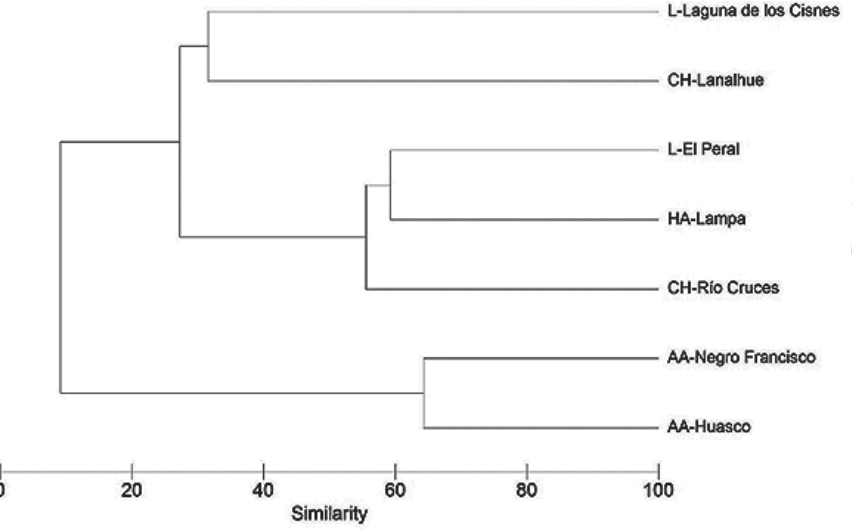
Figure 1. Bray-Curtis similarity tree diagram of the wetlands analysed. AA= High-Andean wetlands (Huasco and Negro Francisco), HA= man-made wetland (Tranque San Rafael), CH= wetland complexes (Lago Lanalhue and Río Cruces), L= Lakes (El Peral, Los